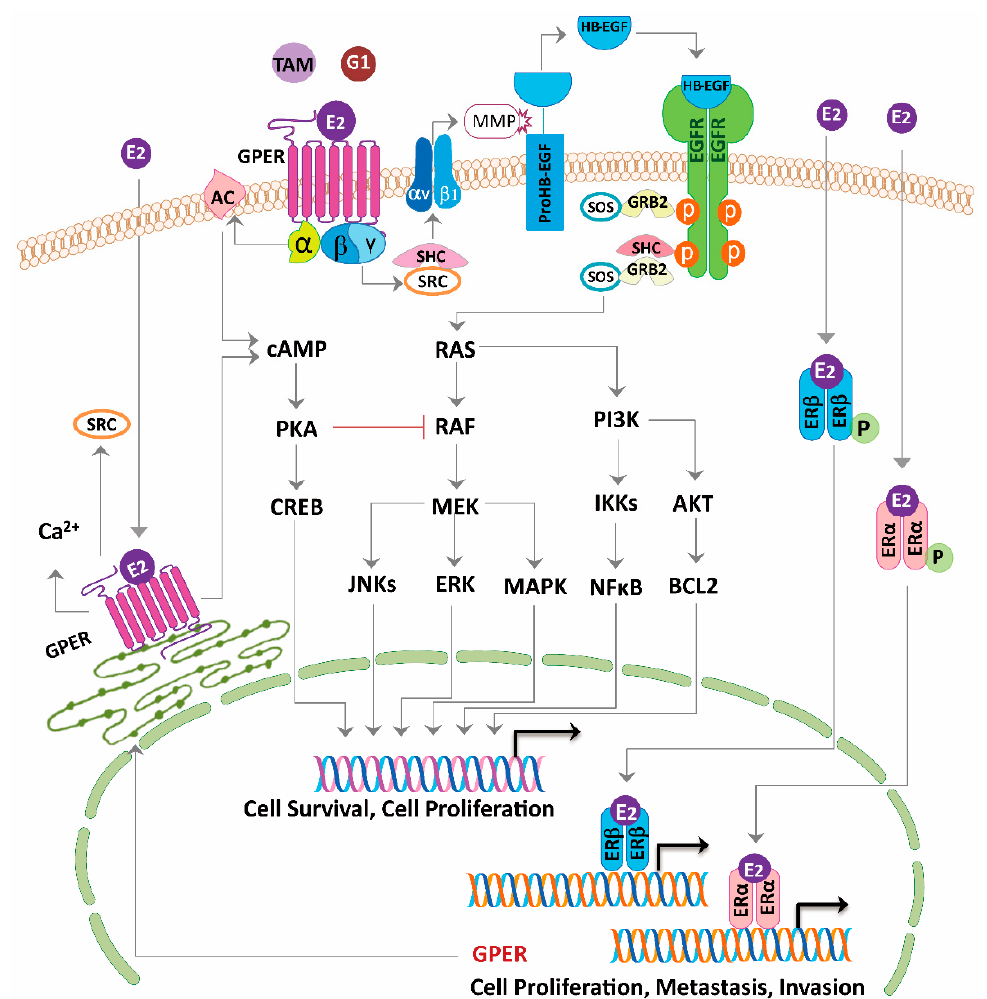
Figure 3. Model of estrogen signaling pathways in cancer. 17 β -estradiol (E 2 ) activates ER α or ER β to induce the receptor dimerization, and subsequently acts as a transcription factor or interacts with other transcription factors binding to the promoter region of the target genes. E 2 , tamoxifen (TAM) or G1 activate the G-protein Coupled Estrogen Receptor (GPER) distributed in the nucleus, cytoplasm, and plasma membrane. Activation of GPER located in the plasma membrane stimulates steroid receptor coactivator (SRC) through a G βγ -subunit protein pathway. The β and γ subunits of the G protein activate the SRC tyrosine kinase, which binds to the integrin ανβ 1 through the SHC adapter protein. The complex activates the matrix metalloproteinase (MMP), which then cleaves the pro-heparin-binding EGF-like growth factor (proHB-EGF) and releases the heparin-binding EGF-like growth factor (HB-EGF) into the extracellular space. The free HB-EGF then transactivates the epidermal growth factor receptor (EGFR). Phosphorylation of EGFR in turn activates the downstream pathways, which can induce rapid non-genomic effects, or genomic effects regulating different genes transcription and leads to cell survival and proliferation. On the other hand, through GPER, E 2 , tamoxifen or G1 is able to stimulate the adenylyl cyclase activity through a G α -subunit protein pathway, which then leads to the protein kinase A (PKA)-mediated suppression of the EGFR-induced ERK activity. Thus, via the GPER, E 2 , tamoxifen or G1 may balance the ERK activity by stimulating two distinct G-protein signaling pathways that have opposing effects on the EGFR-to-MAPK axis. Long-term tamoxifen treatment could sensitize the cancer cells through E 2 -stimulated upregulation of GPER and translocation from the endoplasmic reticulum to the plasma membrane.